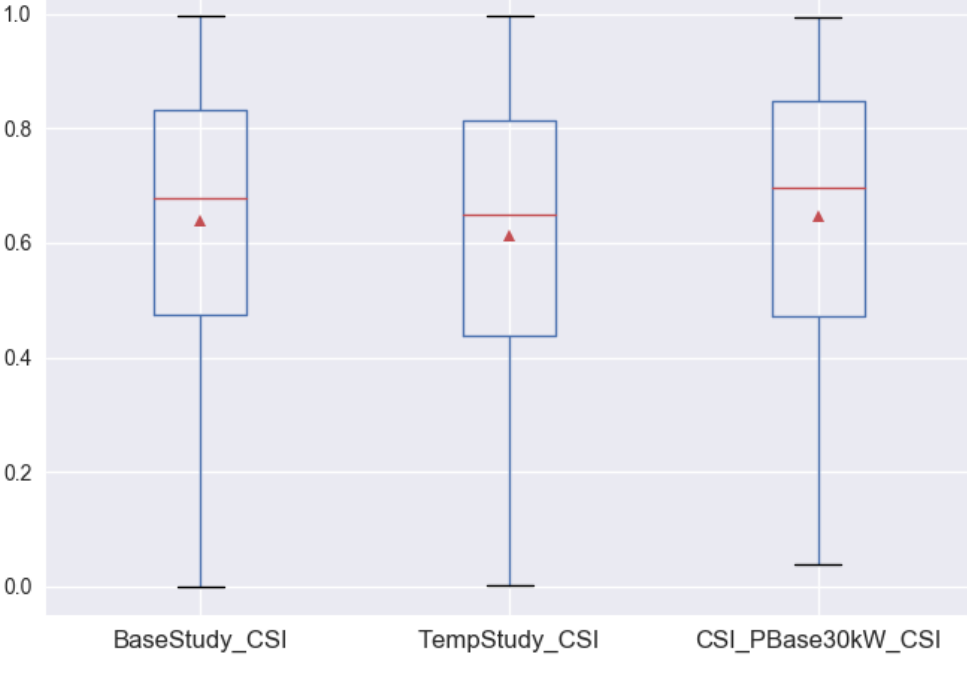
Figure 9. Average CSI values over a year for different scenarios for the standard (30 kW P Base ) setting. Note that only charging processes with a CSI value of less than 1.0 are reflected here.